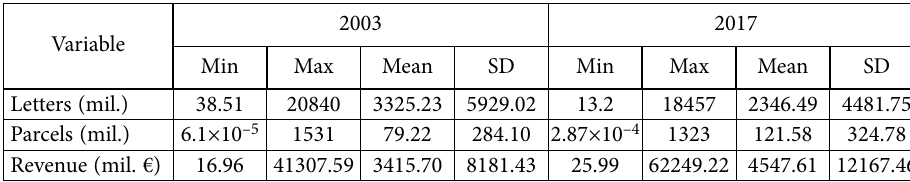
Table 2. Average descriptive statistics for output variables (source : calculated by the authors based on data from Universal Postal Union (2019)) Variable